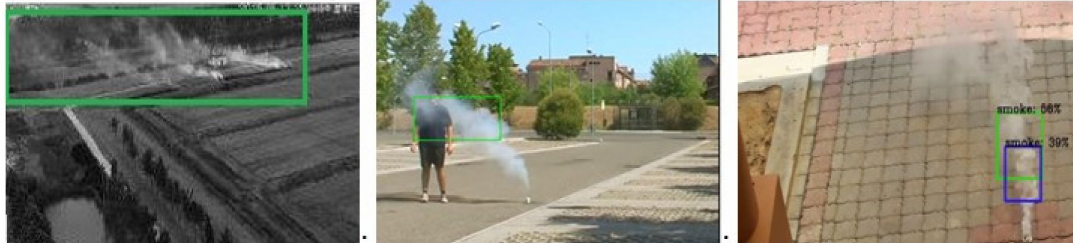
Figure 1. Unsatisfactory examples of region-based smoke detection